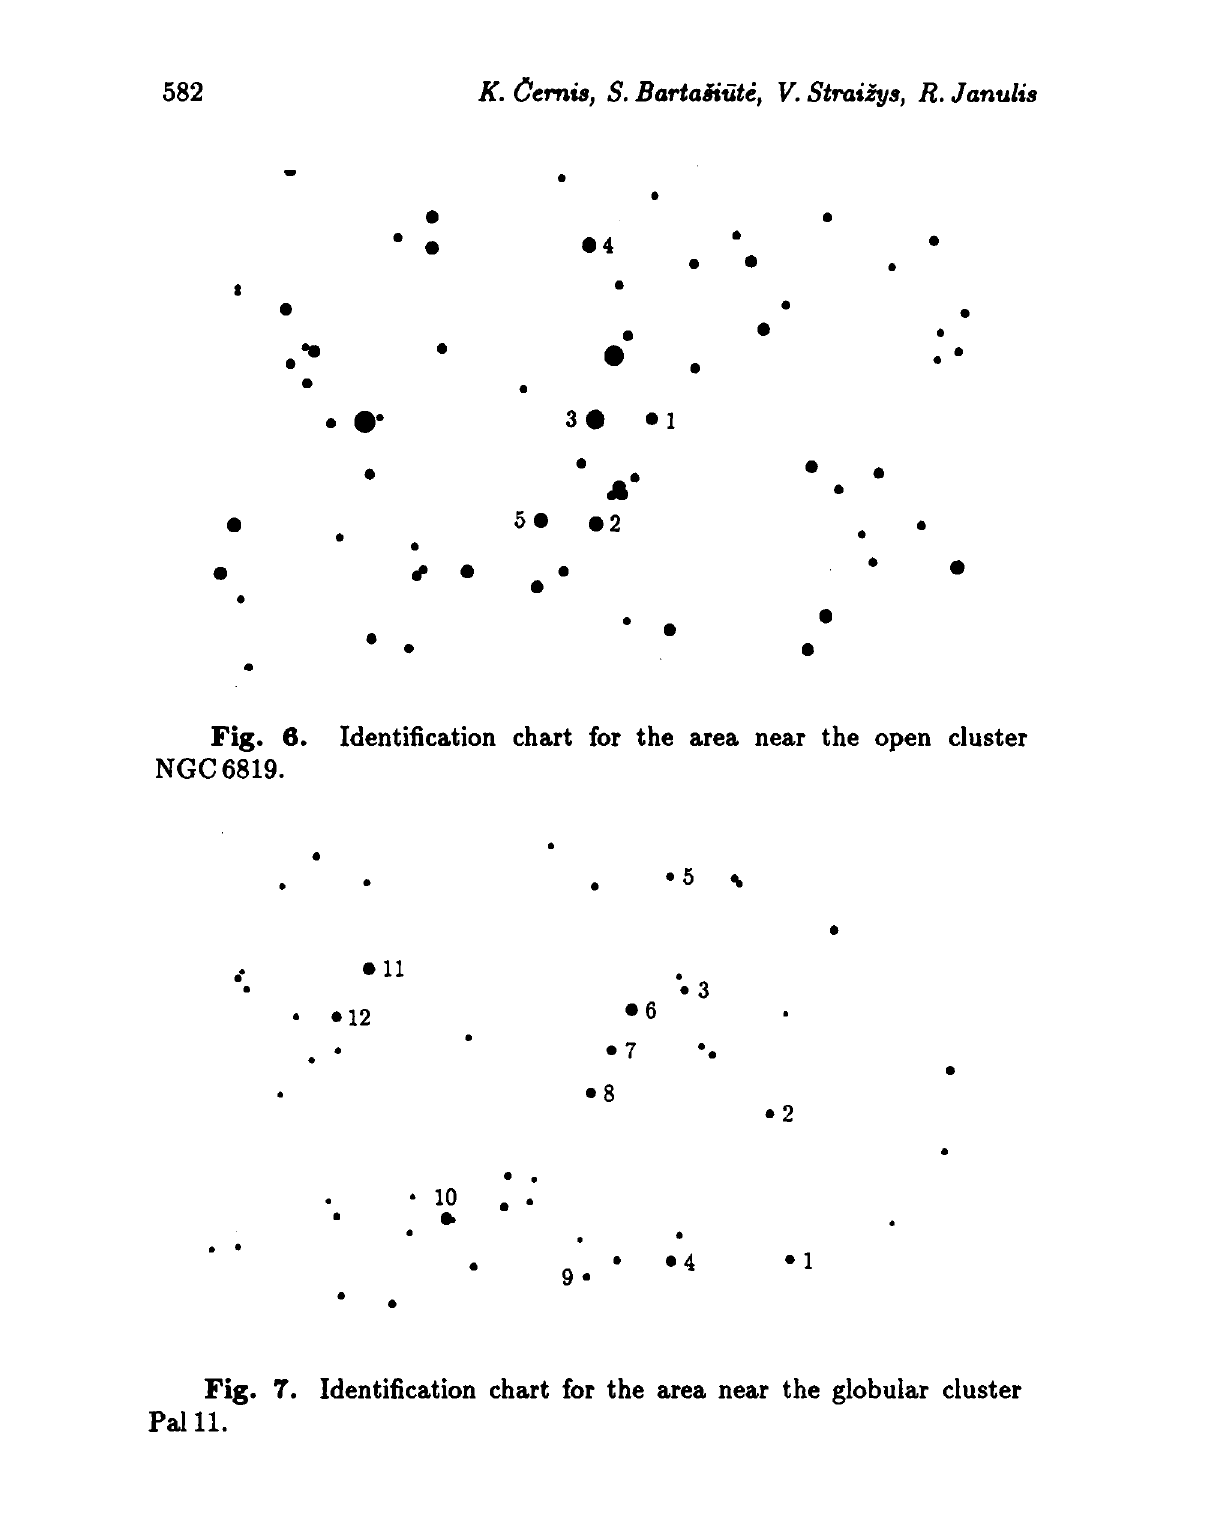
Fig. 7. Identification chart for the area near the globular cluster Pal